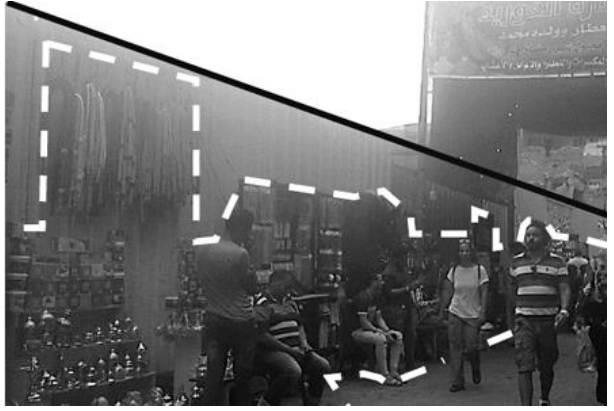
Figure 20. The alignment of shops with the fence.